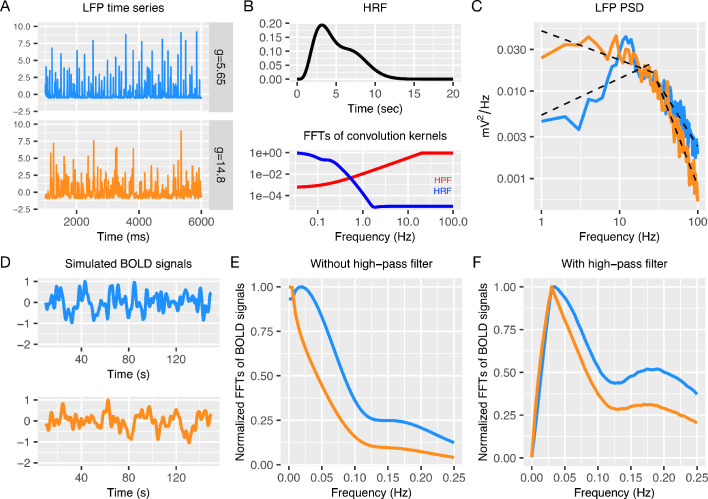
Simulating BOLD signal from LFP data generated by the recurrent model.Panel A shows two example LFP time-series for different values of E:I ratio or g (blue, g = 5.65; orange, g = 14.8). Panel B shows the hemodynamic response function (HRF) from Magri et al., 2012 (top) and the PSDs from Fast Fourier Transforms (FFT) (bottom) on the HRF (blue) and a high-pass filter (HPF) (red). Panel C shows LFP PSDs. BOLD signal was simulated from LFP data as the result of an inverse FFT of the product of multiplied HRF, HPF, and LFP spectra: FFT(BOLD) = FFT(LFP)FFT(HPF)[FFT(HRF) + η], where η is a constant white noise term. Panel D shows the simulated BOLD signals from this process. Panels E and F show the PSD when a high-pass filter was or was not used. In particular, BOLD spectra in Panel F show the distinctive properties such as peak frequency (≈ 0.03 Hz) and low frequency to high frequency power ratio (from 1.5 to 4) observed in previous resting-state fMRI studies (Alcauter et al., 2015; Allen et al., 2011).